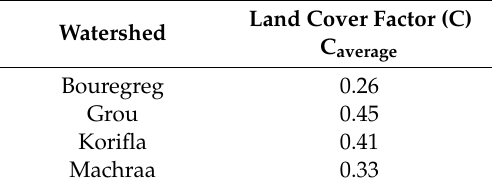
Table 10. Average vegetation cover factor C for each watershed.